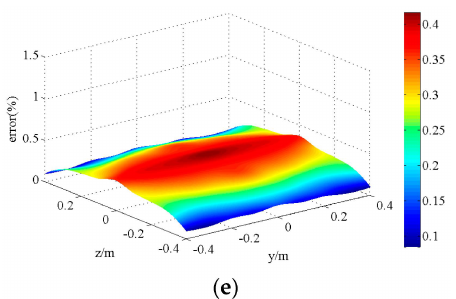
Figure 11. The relative errors between analytical values and experimental values of flux density: ( a ) in the plane of x = 0 m; ( b ) in the plane of x = − 0.1 m; ( c ) in the plane of x = − 0.2 m; ( d ) in the plane of x = − 0.3 m; and, ( e ) in the plane of x = − 0.4 m.